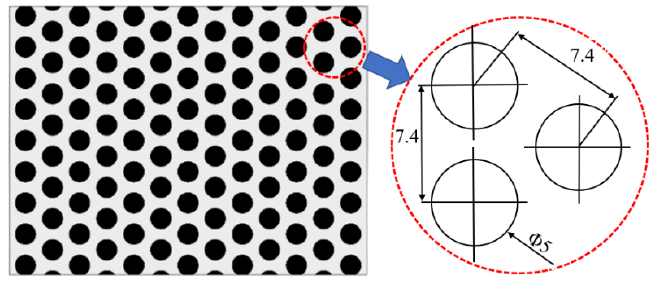
Figure 4. The porous plate.